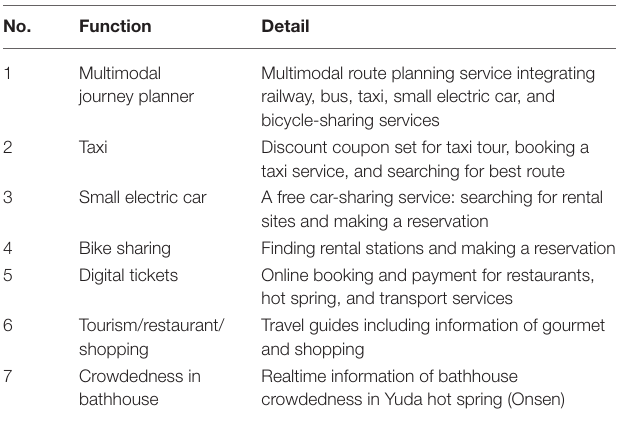
FIGURE A1 | Integration of various forms of transport services into a MaaS platform. Access from: https://maas-y.com/ . TABLE A1 | Functions combined in a single application and web portal.